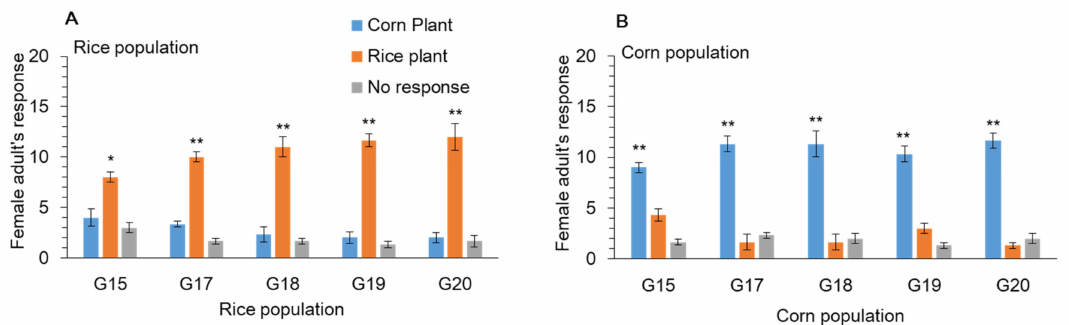
Figure 6. Response of Spodoptera frugiperda female to rice and corn plants in Y-tube, when reared on ( A ) rice and ( B ) corn plants for 20 generations. Data are means ± SE. Asterisks * and ** show significant differences in different host plants ( p < 0.05) based on post hoc Tukey’s HSD